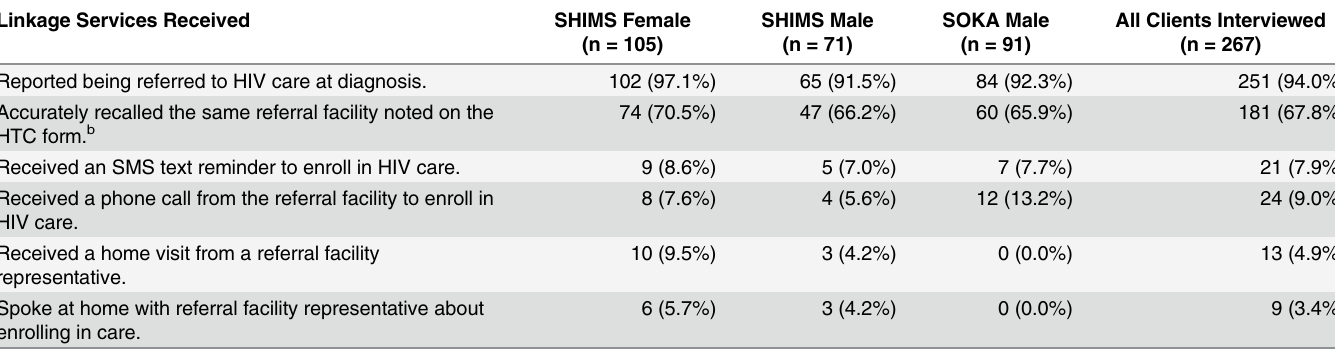
Table 3. Interviewed client self-reported linkage services, by study-gender group a